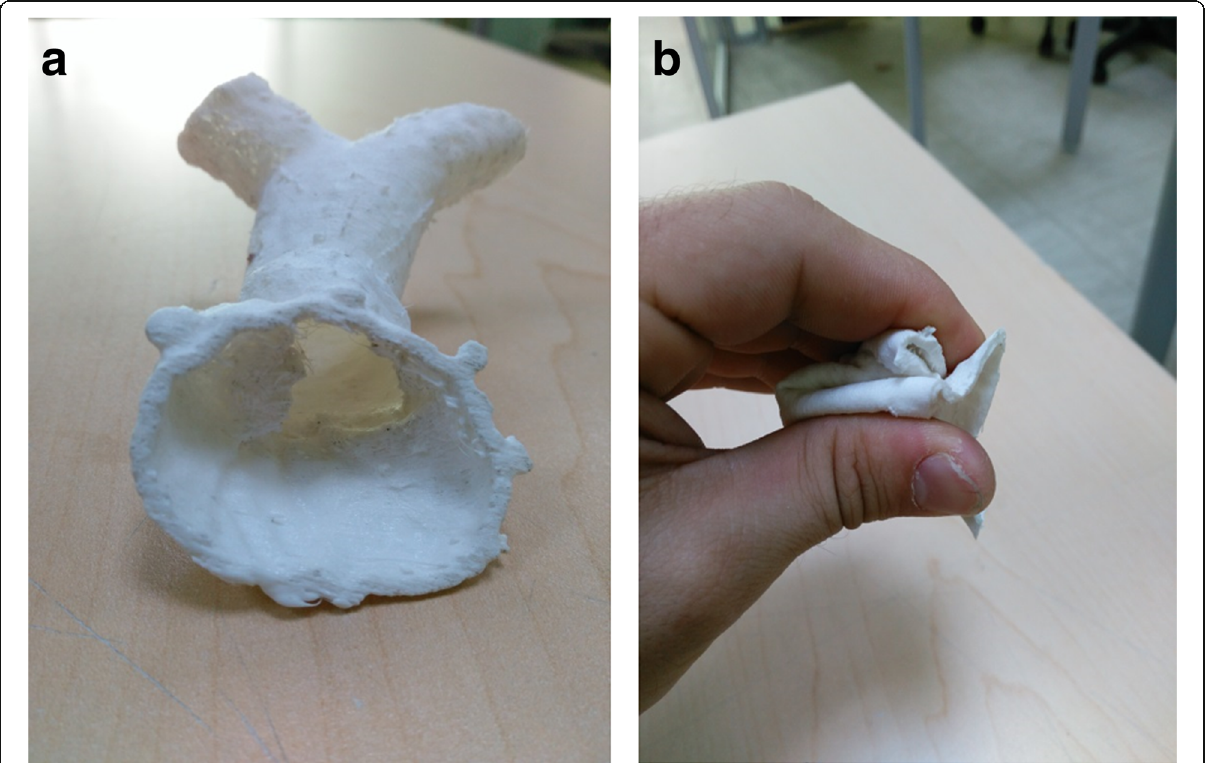
Fig. 3 Example of the right ventricle outflow tract and main pulmonary artery print in flexible, non-transparent material in its normal ( a ) and squeezed ( b )